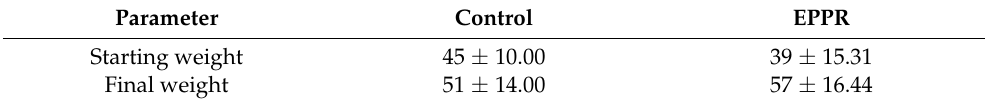
Table 3. Mean ± SD of the body weight (grams) of mice treated with a single dose of EPPR. Parameter